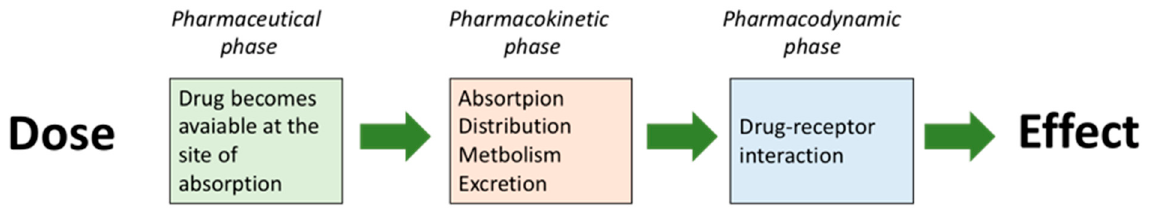
Figure 2. The three phases between the administration of a bioactive compound (drug) and the physiological effect of the bioactive compound.